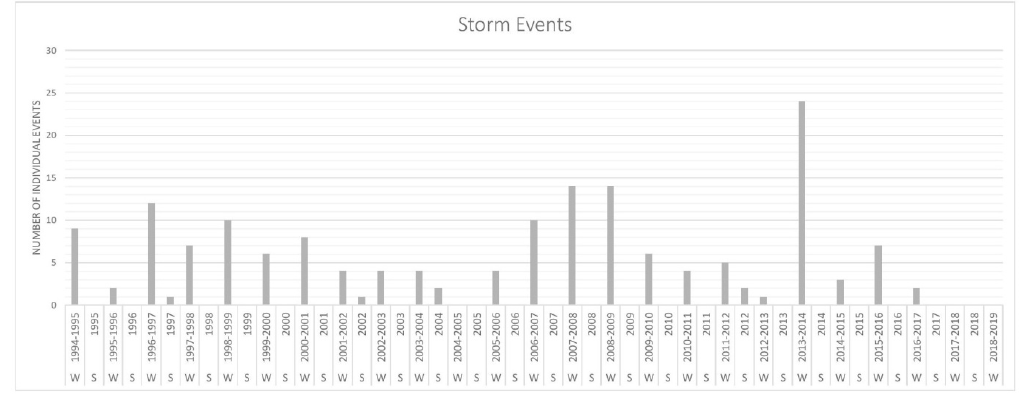
Figure 7. Number of storm events in the preceding 25 years incident on Dingle Bay.